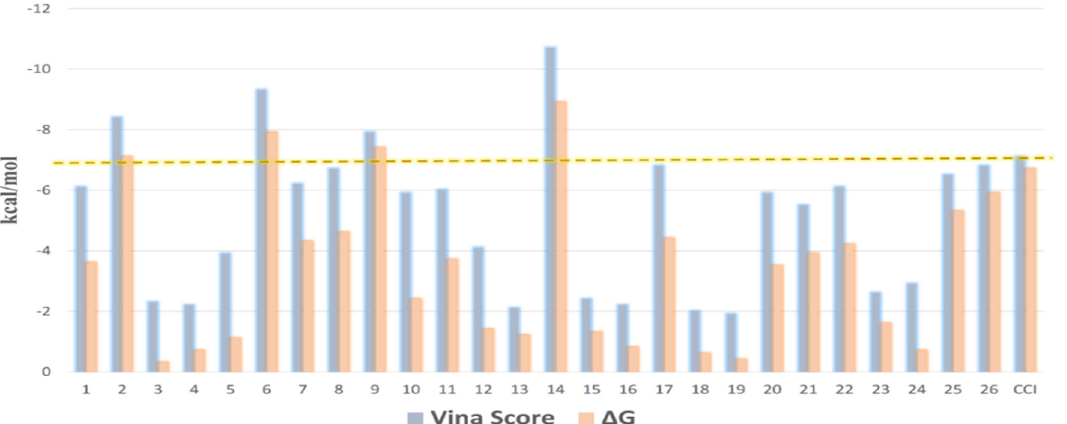
Figure 11. Docking scores of compounds 1–26 inside the active site of MMP1 along with their cal- culated Δ G s. The − 7 kcal/mol score was set as a cutoff to select the best hits. CCl = co-crystalized